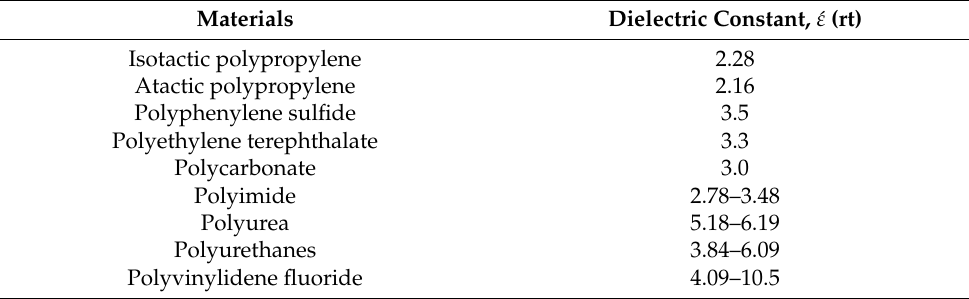
Table 1. Dielectric materials for capacitor insulations. Adapted from